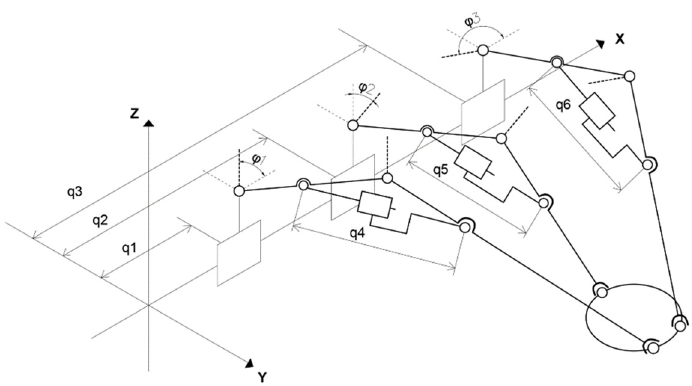
Figure 1. The kinematic scheme of the 6DOF PKM structure.